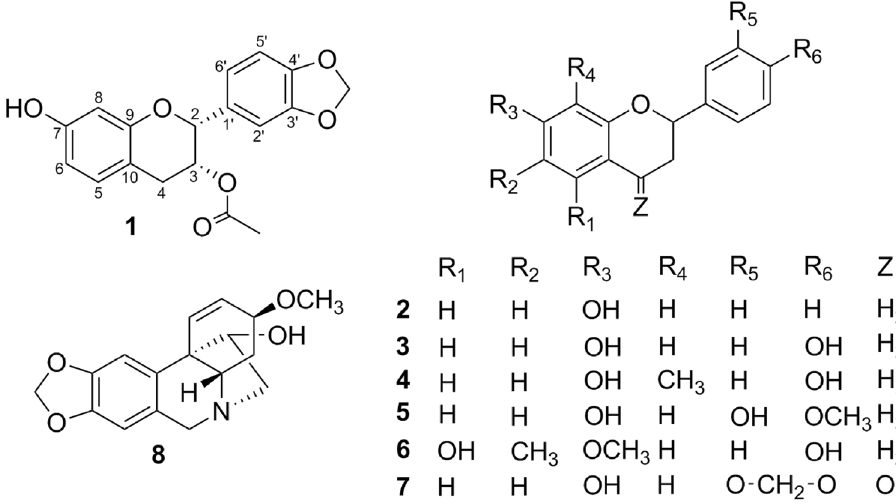
Figure 1. Structures of 1 – 8 isolated from Zephyranthes ajax Hort.